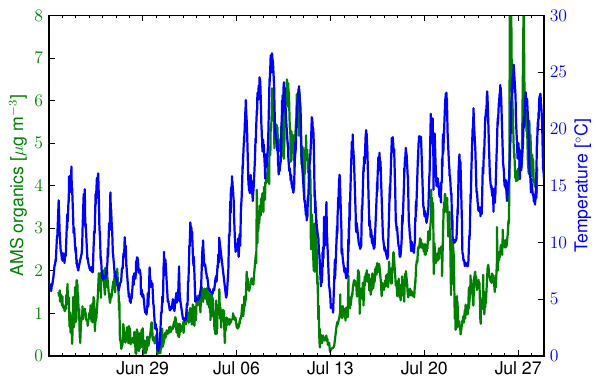
Fig. 1. Organic aerosol concentration measured by the AMS at Raven’s Nest as well as the temperature measured at Raven’s Nest versus time for the entire WACS 2010 campaign. The x-axis repre- sents local Pacific daylight